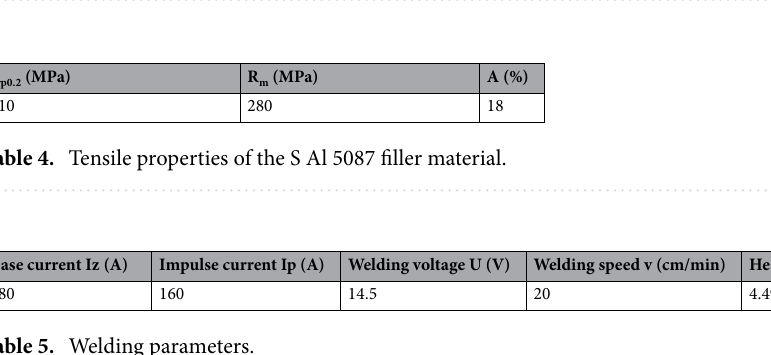
Table 5. Welding